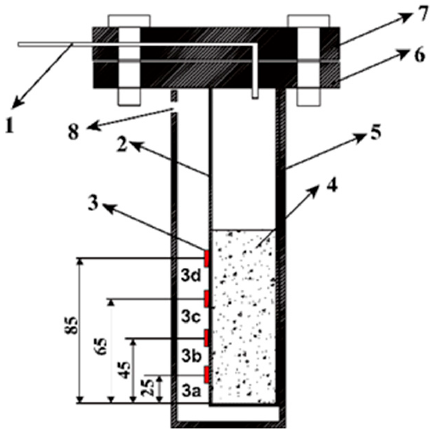
Figure 5. ( a , c ) SEM images of sample s 3 and ( b , d ) EDS mapping images of selected particles after the 1st and the 20th cycle. Insets of ( a , c ) display the particle size